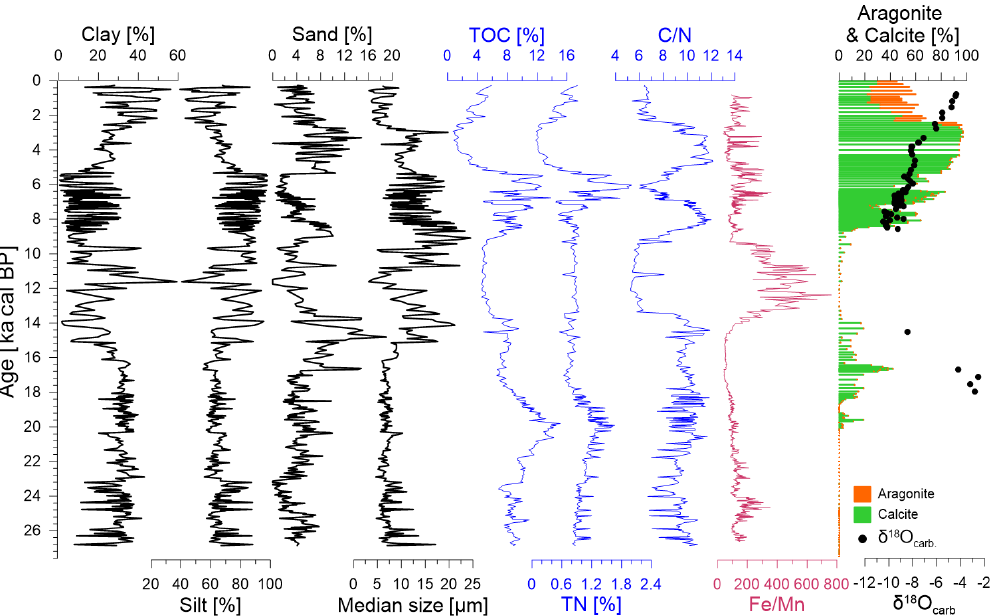
Figure 3. Down-core variations in the grain-size components (clay, silt and sand), median grain size, TOC and TN content, C / N and Fe / Mn ratios, calcite and aragonite content, and δ 18 O carb